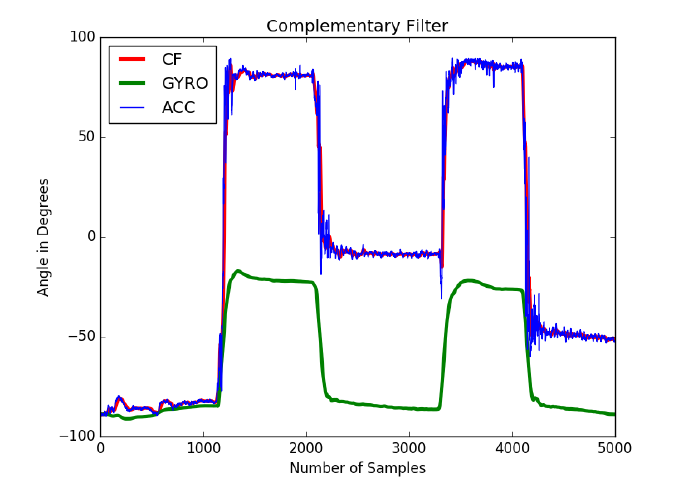
Figure 6. The Complementary Filter returns a smooth and consistent signal, by fusing both accelerometer (ACC) and gyroscope (GYRO) data.